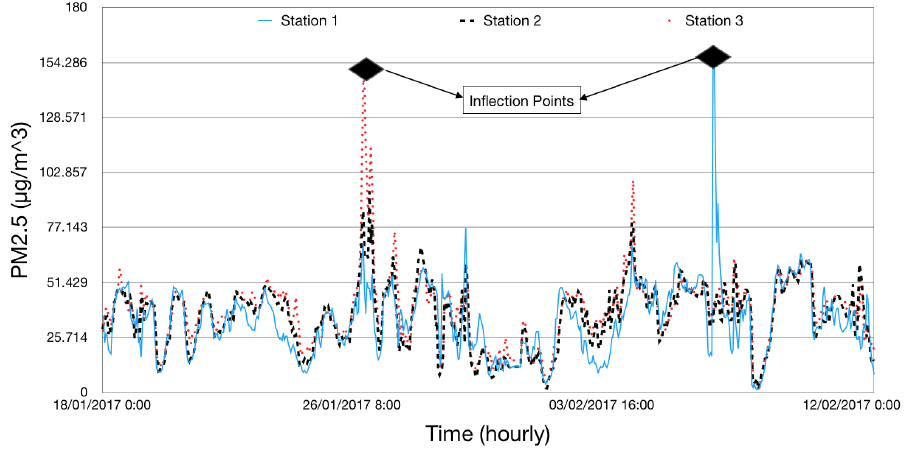
Figure 4. Hourly representation of PM2.5 µ g/m 3 for three